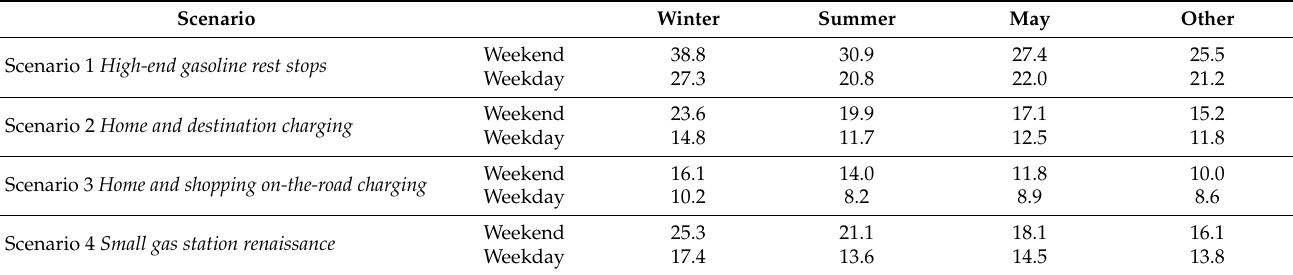
Table 6. Additional peak power (MW) in scenarios.